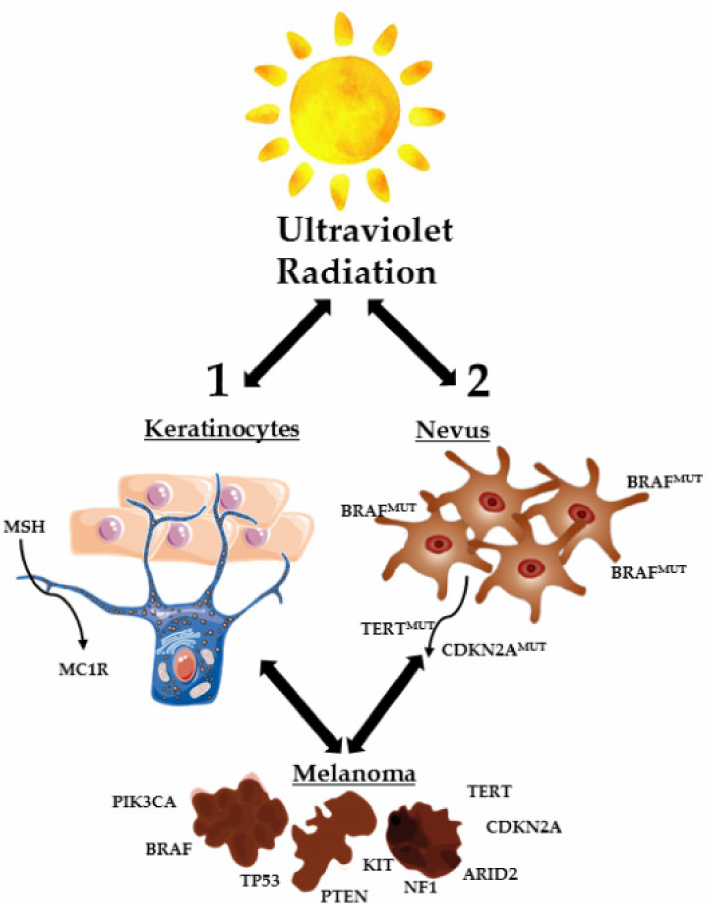
Figure 1. Skin cells exposed to excessive UV radiation. Formation of malignant melanocytes by direct transformation of normal melanocytes and/or transformation of melanocytes into benign nevi, which become malignant (adapted from [20]). ARID2, AT-rich interaction domain 2; BRAF, B-Raf proto-oncogene; CDKN2A, cyclin-dependent kinase inhibitor 2A; KIT, KIT proto-oncogene receptor tyrosine kinase; MC1R, melanocortin 1 receptor; MSH, melanocyte stimulating hormone; NF1, neurofibromin 1; PIK3CA, phosphatidylinositol-4,5-bisphosphate 3-kinase catalytic subunit alpha; PTEN, phosphatase and tensin homolog; TERT, telomerase reverse transcriptase; TP53, tumor protein